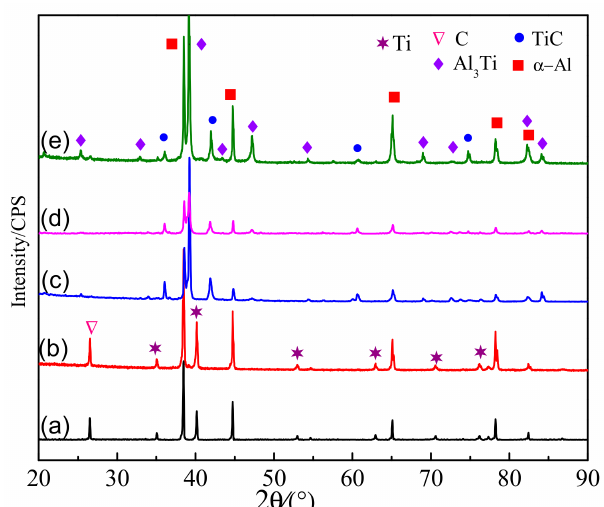
Figure 10. XRD patterns of the quenched samples with di ff erent reaction times: ( a ) 20 s; ( b ) 45 s; ( c ) 60 s; ( d ) 90 s; ( e ) 120